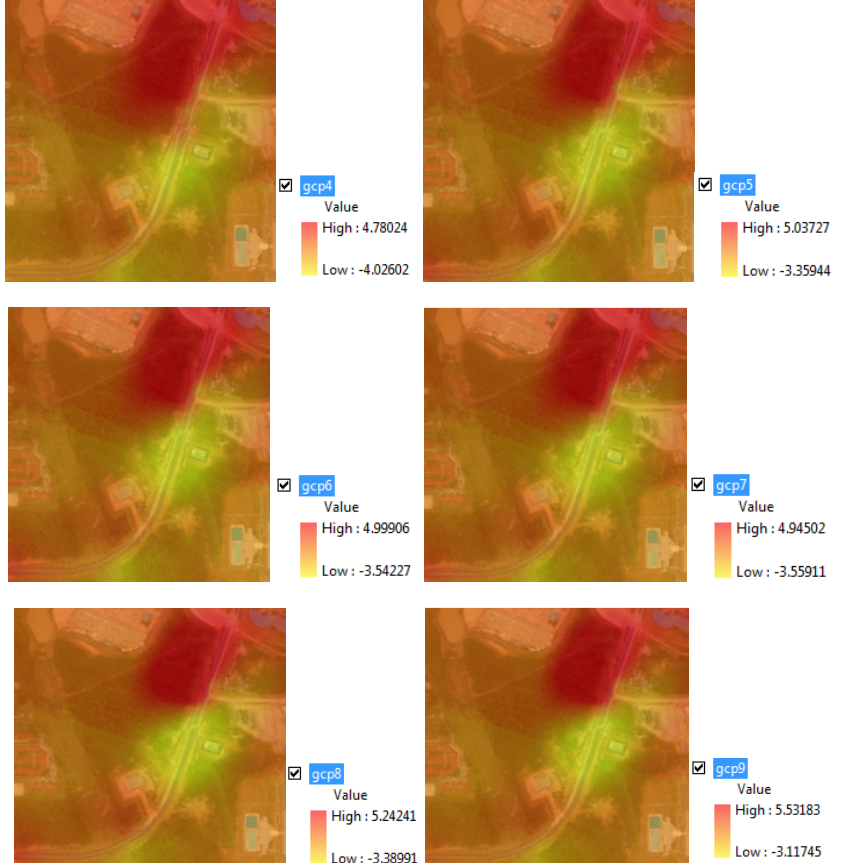
Figure 2. Results on Elevation Error for RTK GPS Iskandar Network (2 minutes) based on different GCP